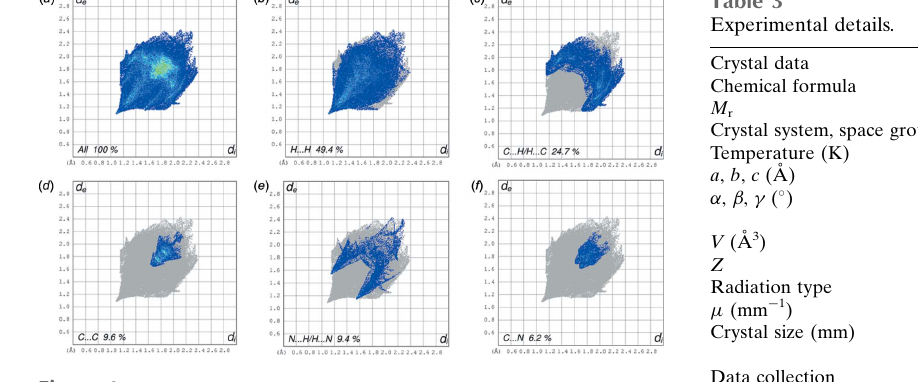
Figure 6 The full two-dimensional fingerprint plot for Form I, and fingerprint plots delineated into H (cid:2)(cid:2)(cid:2) H, C (cid:2)(cid:2)(cid:2) H/H (cid:2)(cid:2)(cid:2) C, C (cid:2)(cid:2)(cid:2) C, N (cid:2)(cid:2)(cid:2) H/H (cid:2)(cid:2)(cid:2) N and C (cid:2)(cid:2)(cid:2) N contacts.